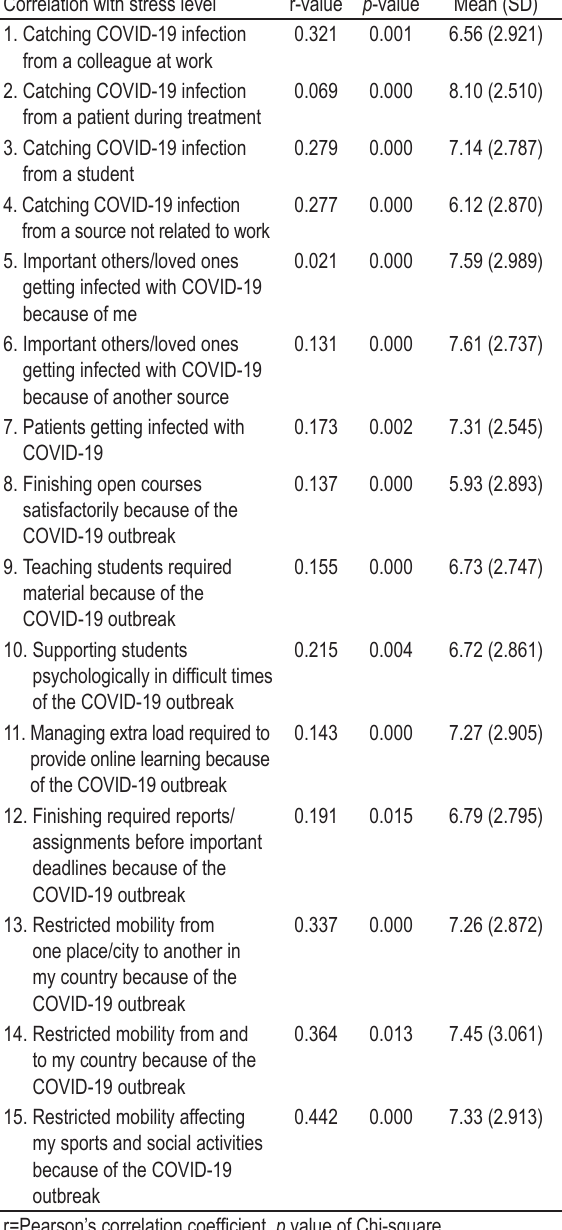
TABLE 3. Factors associated with stress levels among dental academics (n=108)